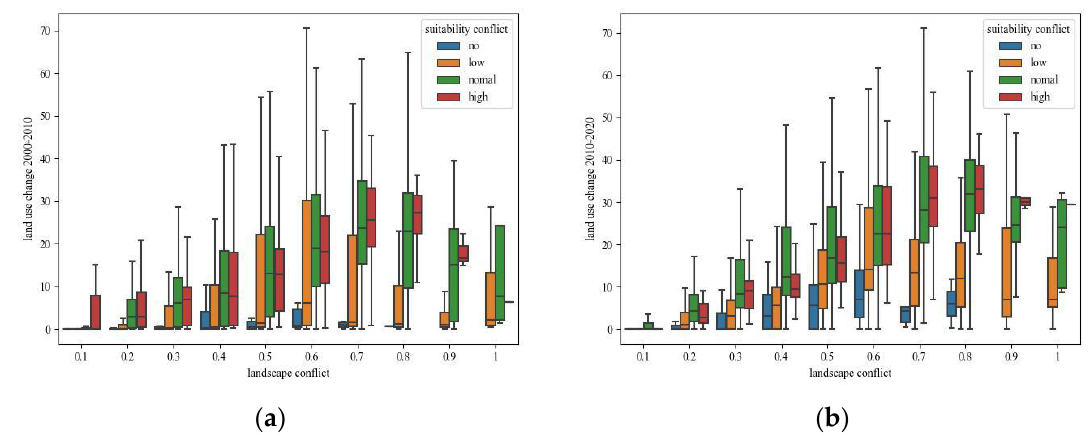
Figure 11. The relationship between land-use change and land-use conflict ( a ) from 2000 to 2010 and ( b ) from 2010 to 2020.